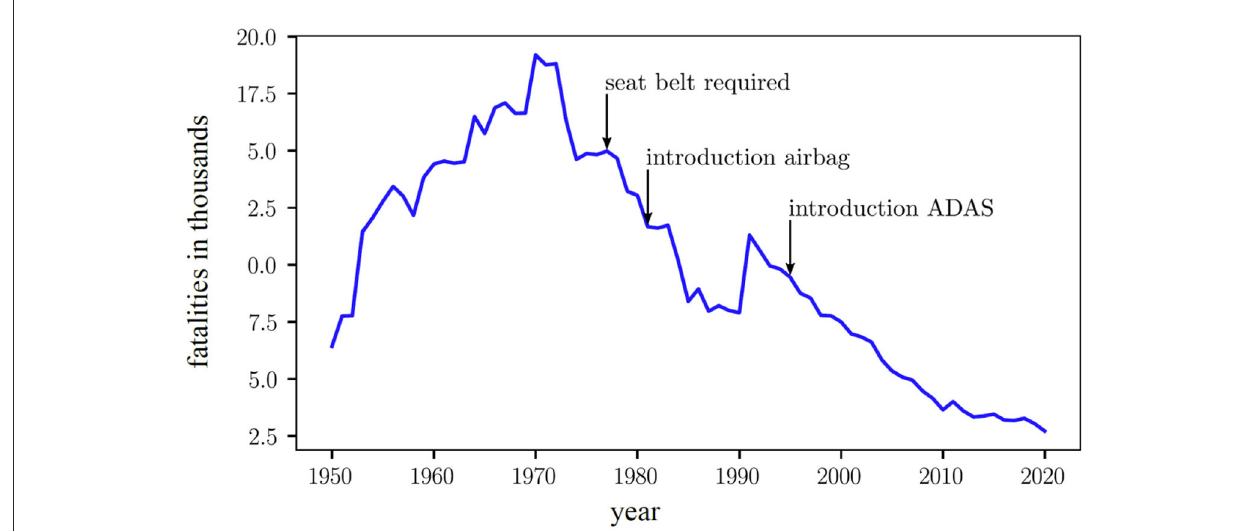
FIGURE1 Fatalities on German roads since 1950 [2]. Detailed description of the data-flow in the simulation framework for scenario-based safety performance assessment, combining scenario, vehicle crash and occupant restraint system simulation. The arrows describe the in- and outputs to the specific simulator